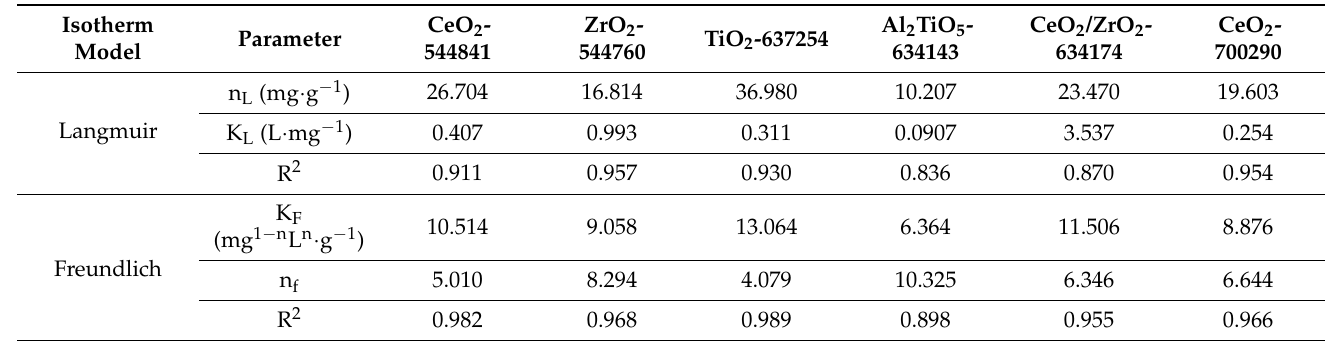
Table 2. Isotherm parameters calculations for the adsorption of CA- 99 Mo on different metal ox- ides NPs.